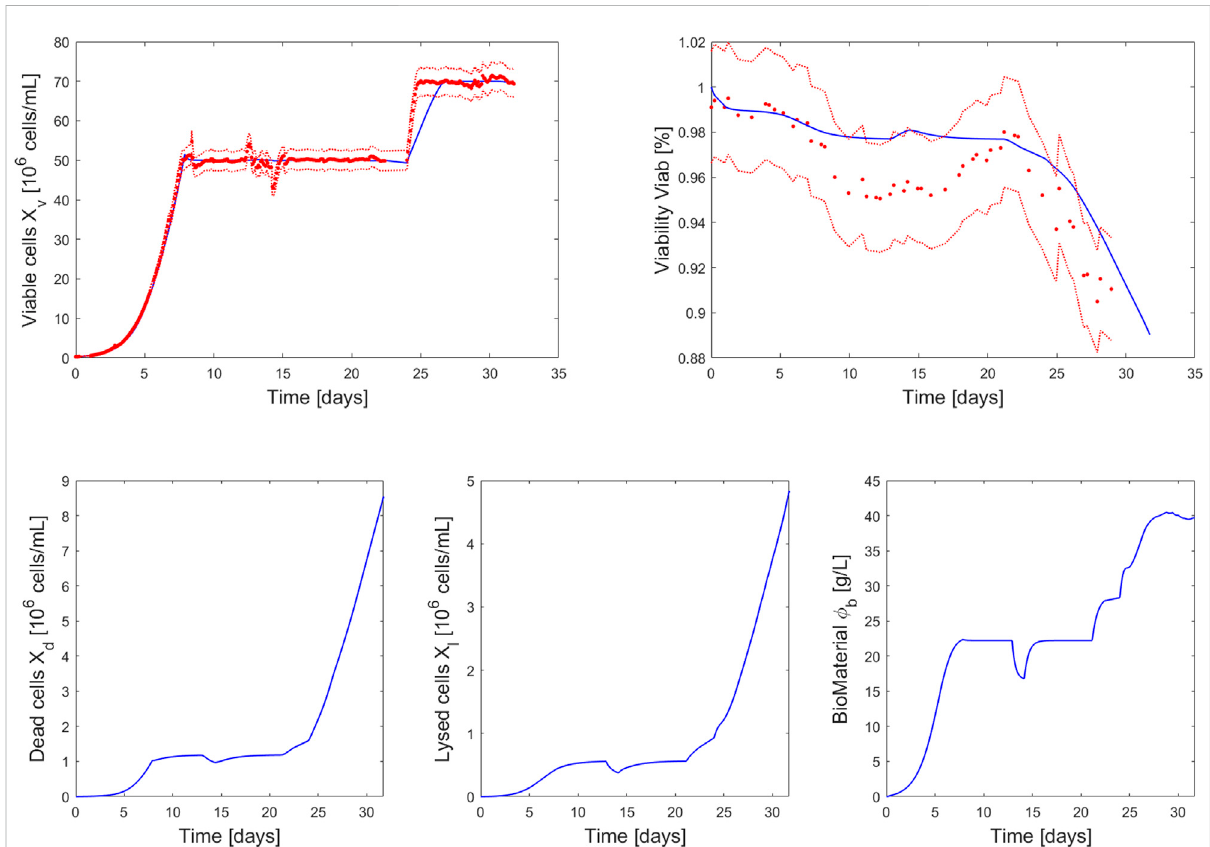
FIGURE 4 Comparison between measurements of 2L perfusion experiment 8 (red dots closed loop PI control of the viable cell density measured on-line at X v , target setpoint value using F b as manipulated variable) and the model simulation (blue curve — closed loop PI control of the viable cell density predicted by the model at X v , target setpoint value using F b as manipulated variable) performed using the parameter values identi fi ed on the whole set of fed-batch experiments 1 – 4. The dashed red lines represent the experimental con fi dence